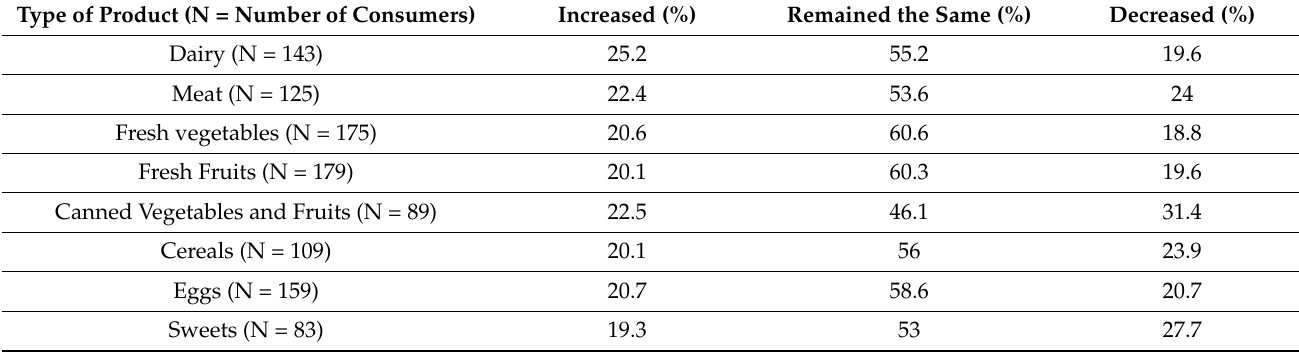
Table 6. Frequency of consumption of the main categories of organic products investigated after the COVID-19